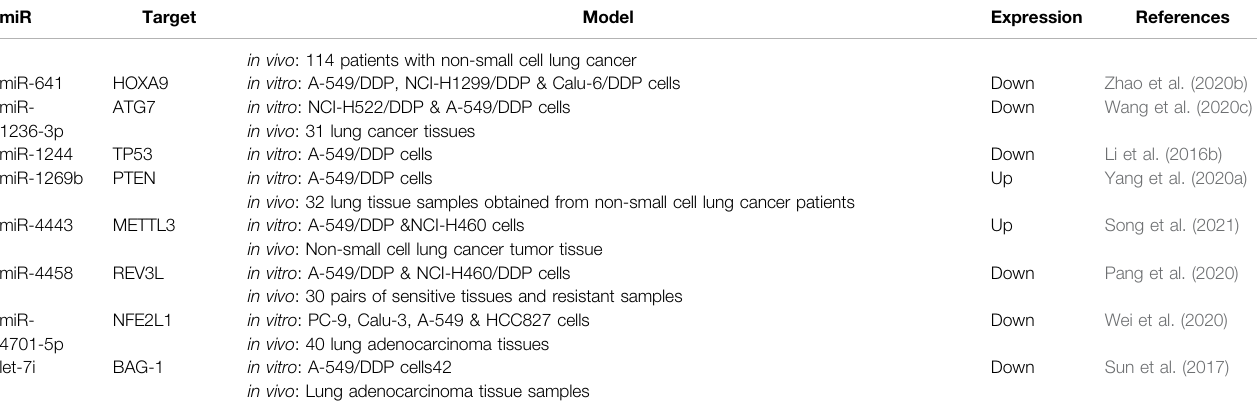
TABLE 1 | ( Continued ) MicroRNAs involved in DDP-chemoresistance in lung cancer.